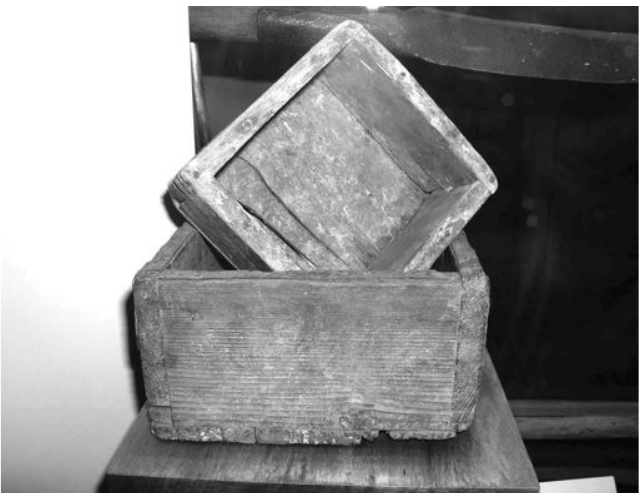
Fig. 7 - Box for sowing the grain made of chestnut.